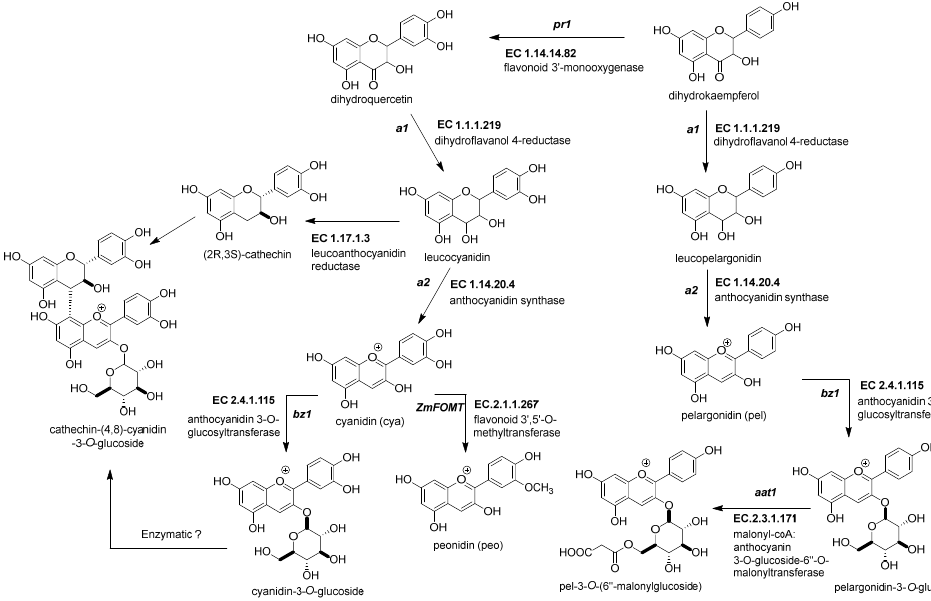
Figure 3. Biosynthetic genes for maize anthocyanin pathway . After the formation of the dihydroflavonol, five enzymatic steps catalyze its biotransformation into acylated maize anthocyanins. Those genes are the following: dihydroflavonol 4-reductase ( ZmDFR , a1 , EC 1.1.1.219), anthocyanidin synthase ( ZmANS , a2 , EC 1.14.20.4), anthocyanidin 3- O -glucosyltransferase ( ZmAGT , bz1 , EC 2.4.1.115), malonyl-CoA: anthocyanin 3- O -glucoside-6 ′′ - O -malonyltransferase ( Zm3MAT , aat1 , EC 2.3.1.171), and flavonoid 3 ′ ,5 ′ - O -methyltransferase ( ZmAOMT , EC 2.1.1.267). The glutathione S-transferase ( ZmGST , bz2 , EC 2.5.1.18) and multidrug resistance protein ( ZmABCC3 and ZmABCC4 , MRP3 and MRP 4, EC 7.6.2.2) are required to deliver them inside the vacuole. References: [30,32].